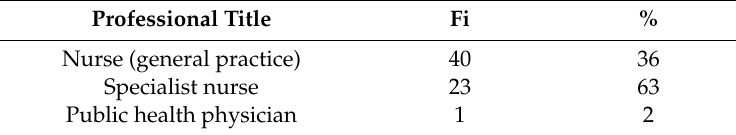
Table 1. Focus group participants profile concerning to professional title.